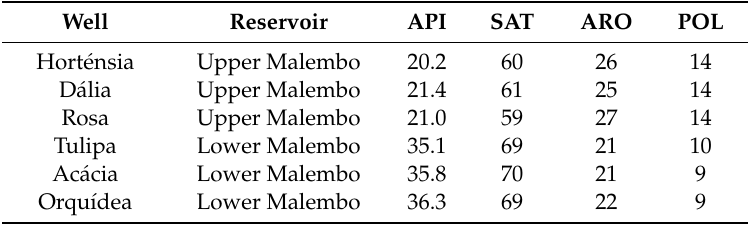
Table 1. API gravities and SARA fractionating for sampled